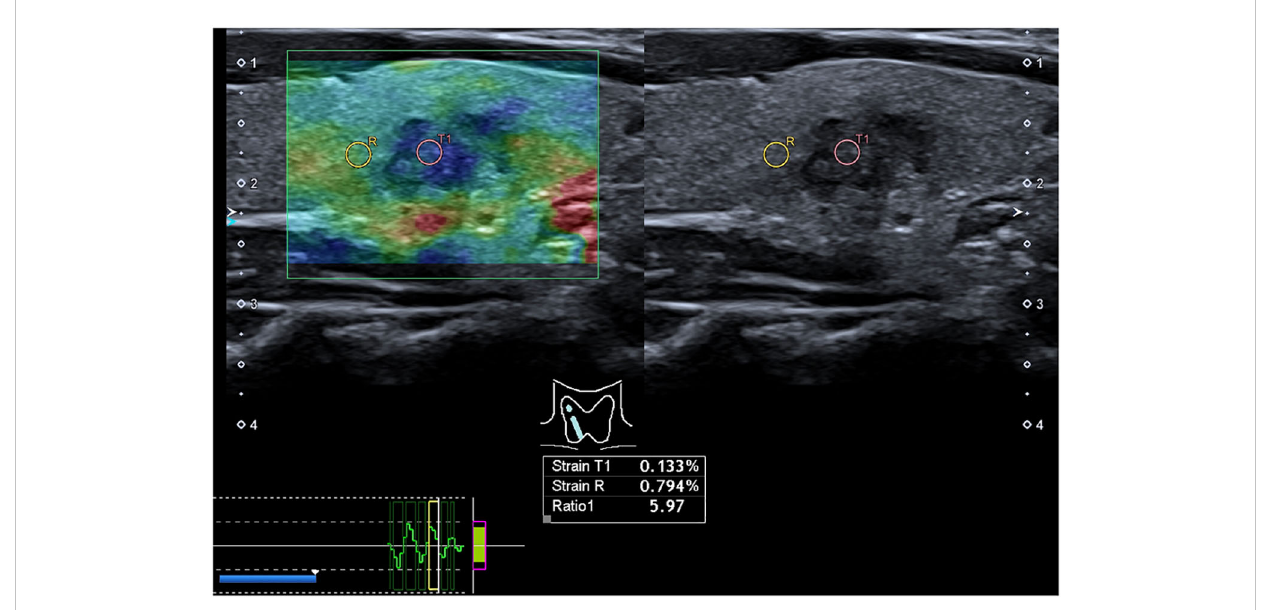
FIGURE 2 Preoperative strain ultrasound elastography images. Preoperative strain ultrasound elastography of a patient with papillary thyroid cancer in the right lobe of the thyroid. The image on the left shows the hardness distribution of tumor tissue (T1) and surrounding thyroid parenchyma (R) in a green sampling box. The color distribution is from red to blue (blue areas indicate hard areas, and red areas indicate soft areas). The right image shows a gray-scale ultrasound image corresponding to the strain ultrasound elastography